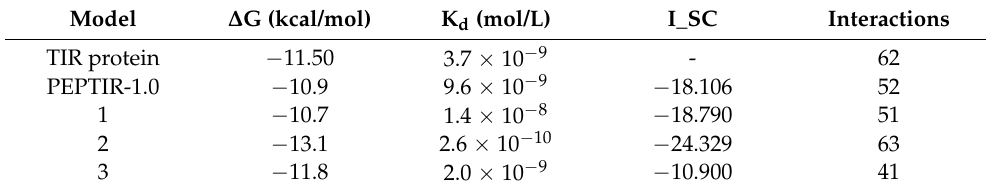
Table 2. Interaction parameters between the analogous peptides and the Intimin protein, obtained with the FlexPepDock and Prodigy Haddock programs. ∆ G: binding affinity, K d : dissociation constant, I_SC: interface energy.